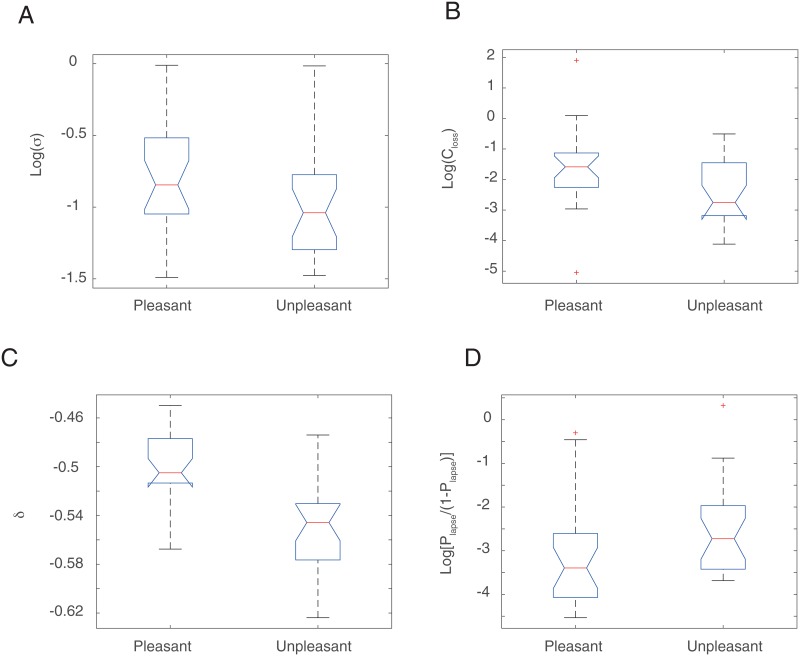
Estimated parameters of the four parameter model in Session 3.A. The noise parameter σ. The means of Pleasant and Unpleasant room participants were not significantly different. B. The relative weight of losses to wins. The means of Pleasant and Unpleasant room participants were significantly different. C. The bias parameter δ. The means of Pleasant and Unpleasant room participants were significantly different. D. The lapse rate. The means of Pleasant and Unpleasant room participants were mildly significantly different. The parameters are shown in the inference space.